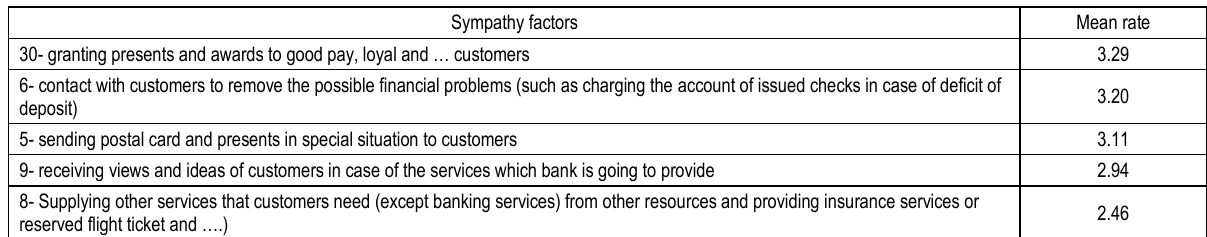
Table 17. Results of mean rate of sympathy factors based on